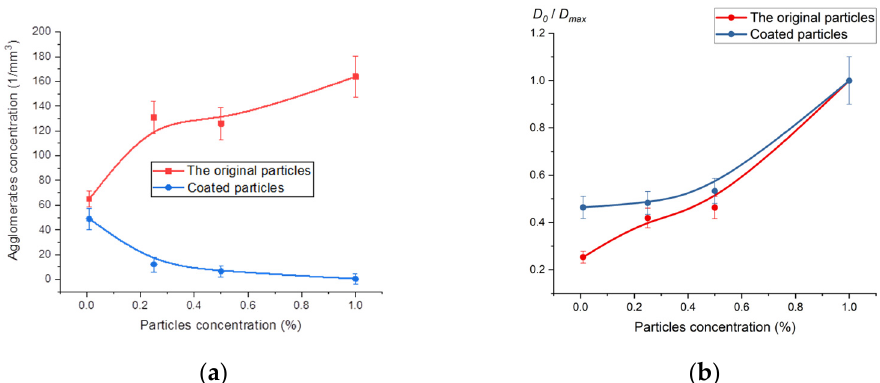
Figure 1. ( a ) Agglomerates concentration N vs mass concentration of submicron reinforcement particles in the polymer composite; ( b ) Scaled average diameter of particles D 0 / D max vs mass concentration of submicron reinforcement particles in the polymer composite.